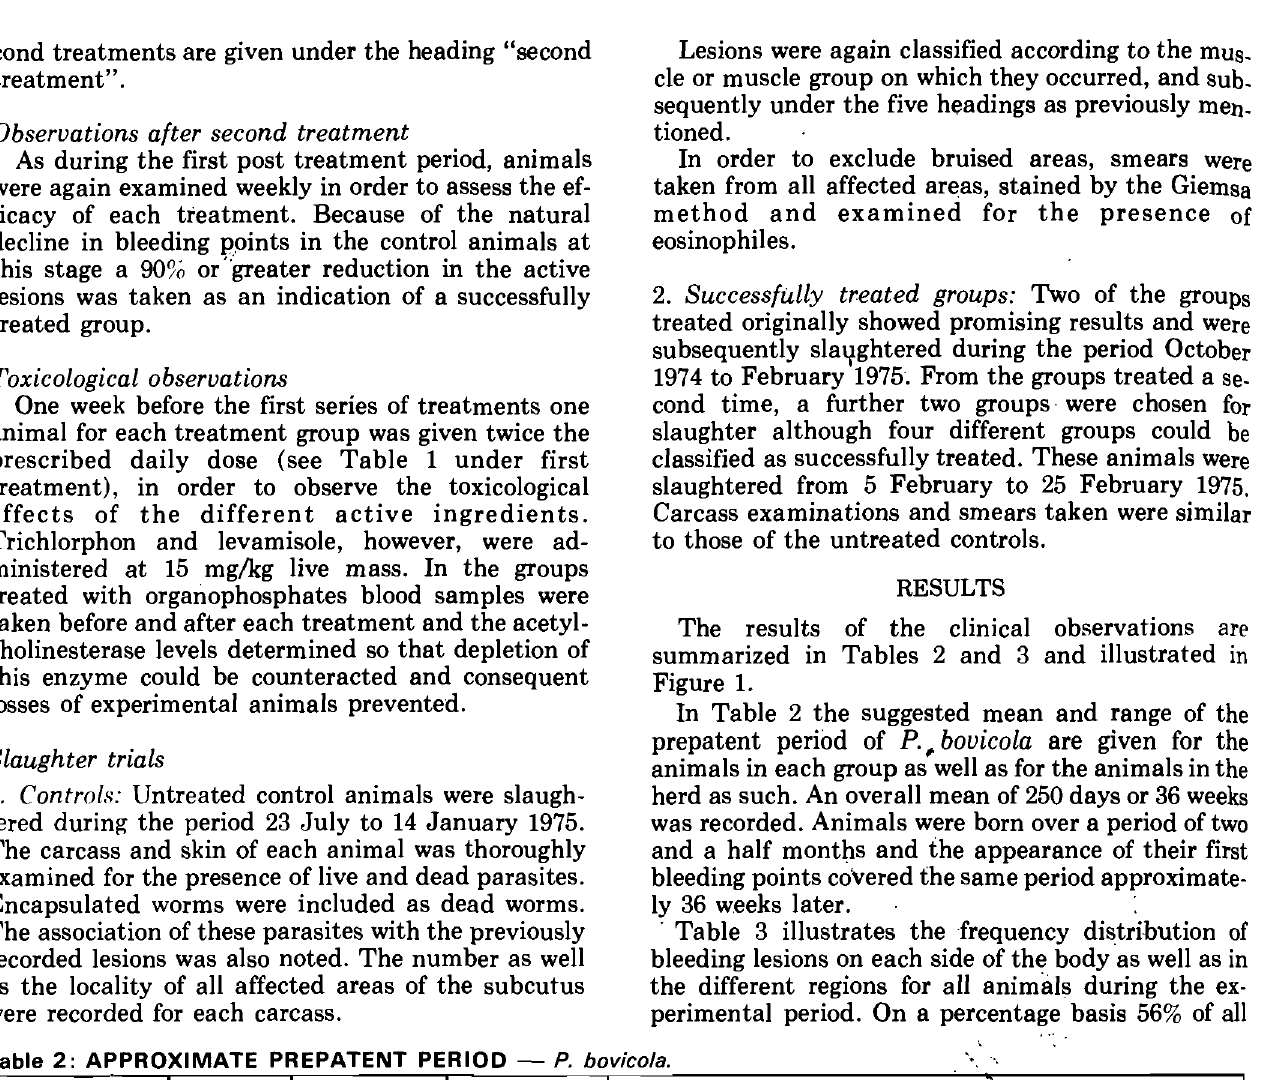
Table 2' APPROXIMATE PREPATENT PERIOD